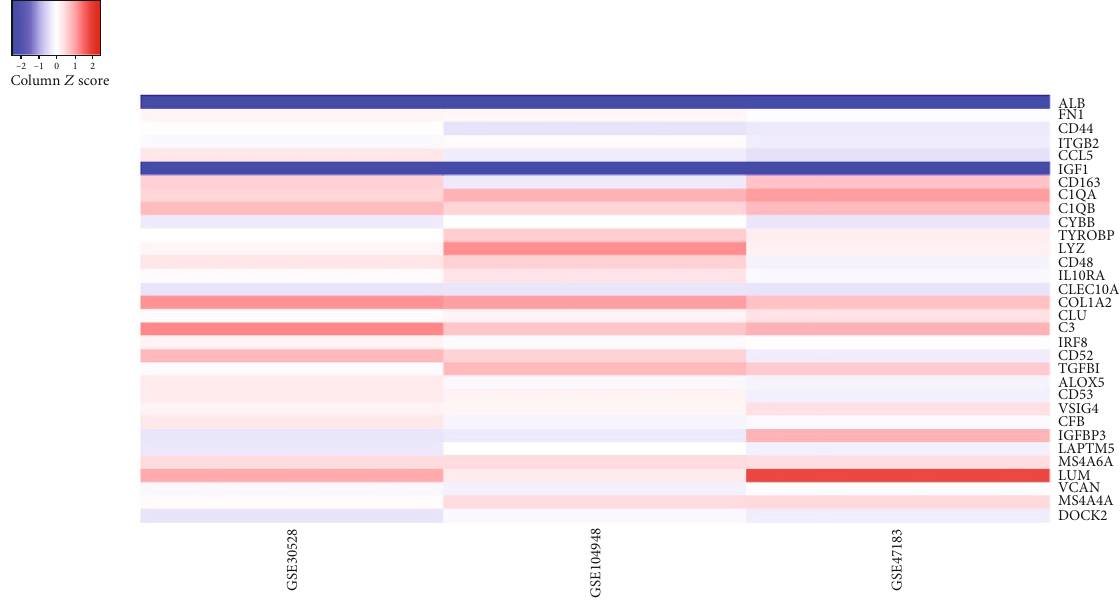
Figure 6: The heat map of the hub genes.